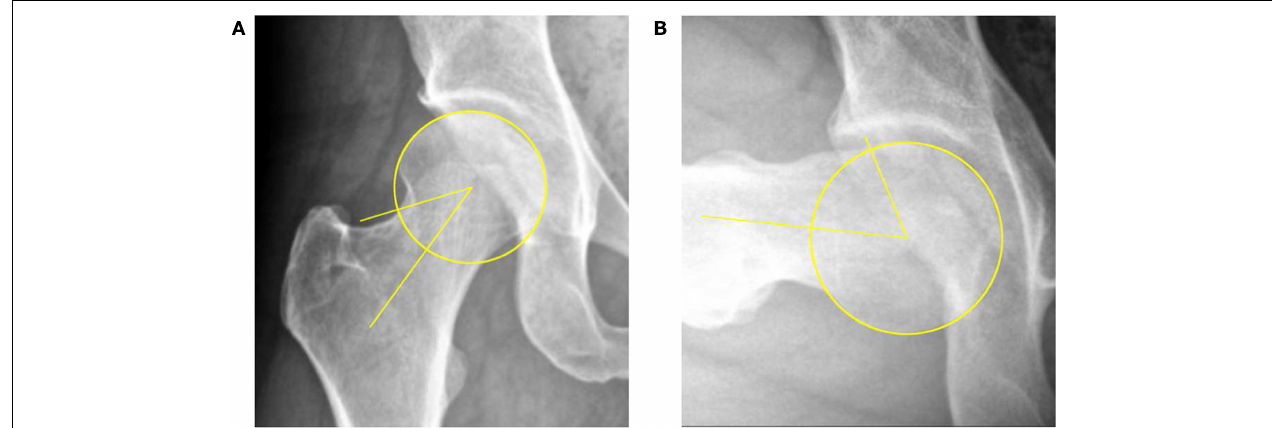
FIGURE 1 | Determination of head–neck offset by measurement of the ααα angle on AP (A) and 90°-Dunn lateral (B) radiographs .